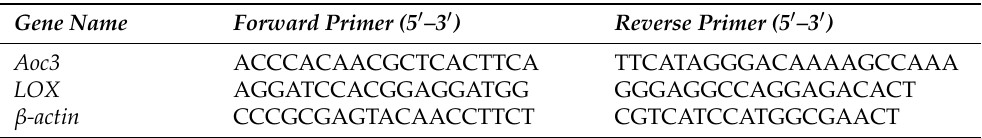
Table 1. Primers sequence for Rattus norvegicus amine oxidase, copper containing 3 (Aoc3), Rattus norvegicus lysyl oxidase (LOX), and Rattus norvegicus β -actin.